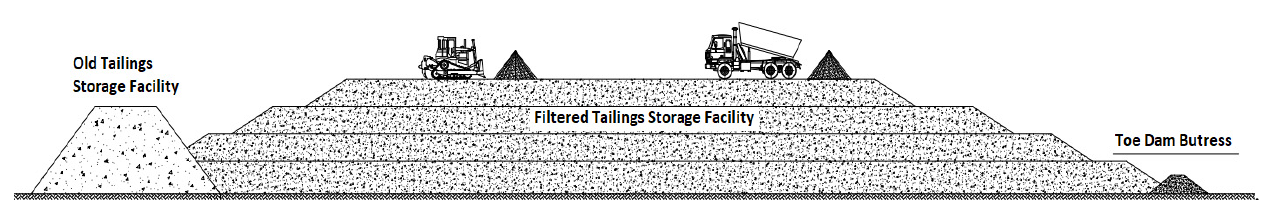
Figure 47. Tambillos Filtered Tailings Storage Facility Typical Cross Section [48,66].